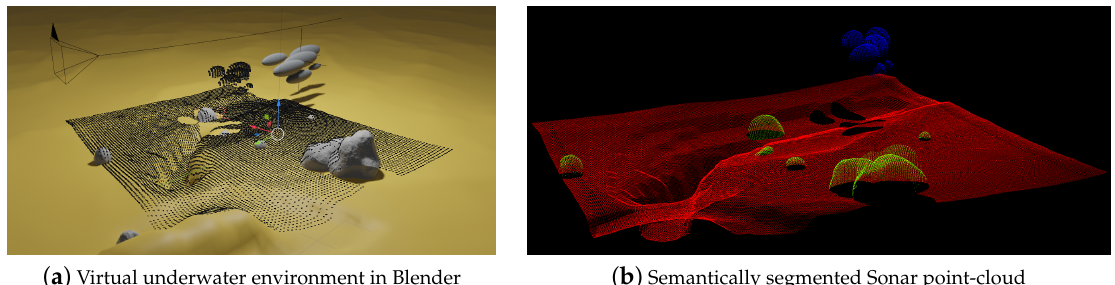
Figure 14. ( a ) The illustration shows an underwater scene modeled in the software Blender. ( b ) Point-cloud acquired from virtual Sonar sensor with semantic